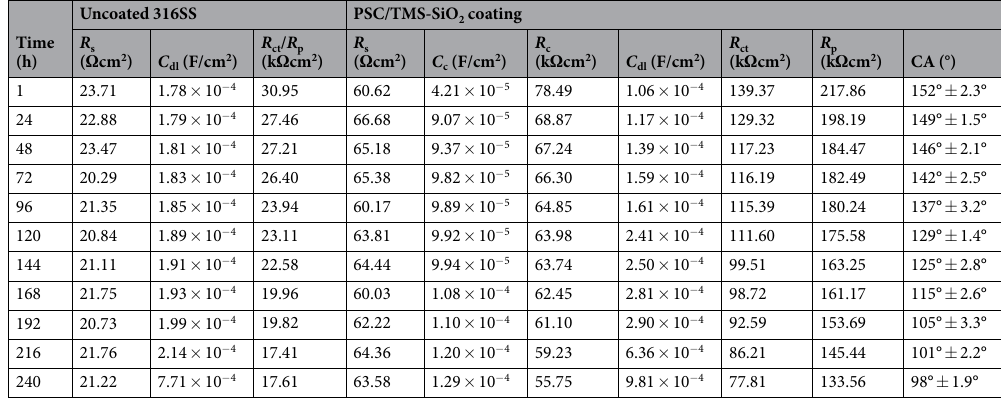
Table 4. Electrochemical parameters obtained by fitting the EIS data of uncoated SS and PSC/TMS-SiO 2 coating with their respective contact angles (CAs) at different immersion time in 3.5%